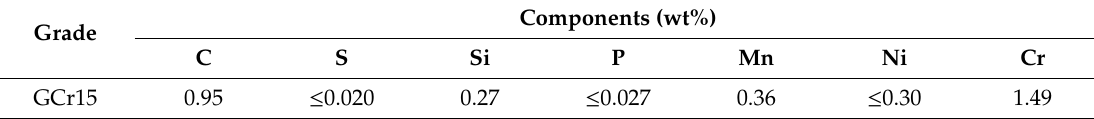
Table 4. Chemical composition of the artificial seawater.